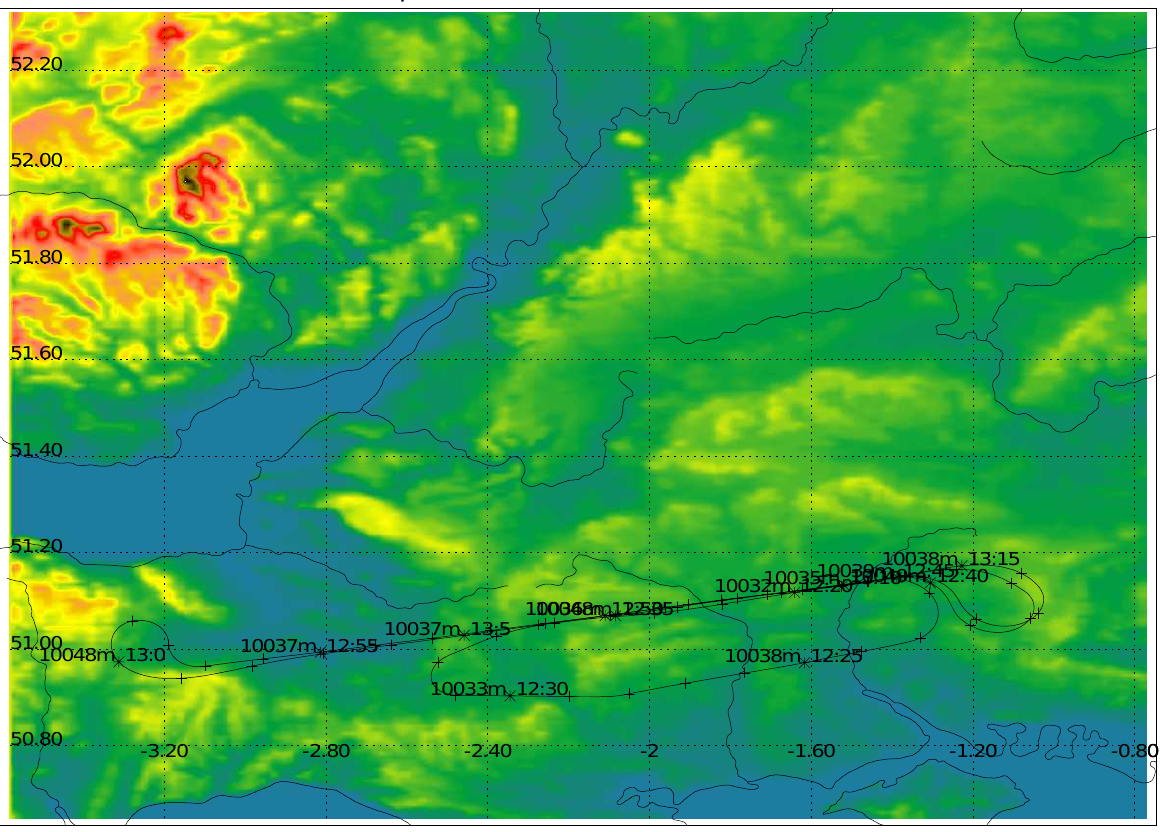
Fig. 3. The aircraft flight path for 13 October 1998. The observing region is from 50.9–51.2 ◦ N and 3.2–1.0 ◦ W. The altitude of the aircraft (near 10km) is also marked, and the local orography is given in green and brown to represent heights above sea